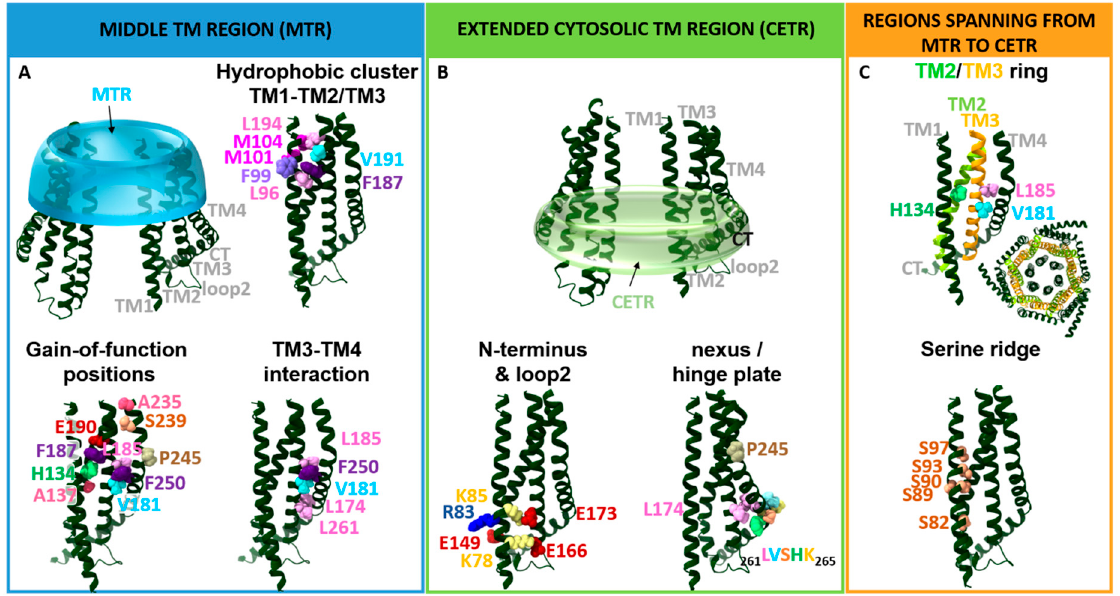
Figure 3. Orai1 mutations. The subunit schemes display so far discovered positions that, upon single substitution, lead to either LoF (indicated by red stop sign, left ) or GoF (visualized by blue circle, middle left ) mutations. The positions that, upon substitution to different residues, can lead to both GoF, i.e., Orai1 H134A, and LoF, i.e., Orai1 H134W, are repre- sented ( middle right ). Disease-/cancer-related mutation positions are marked as black crosses ( right ).